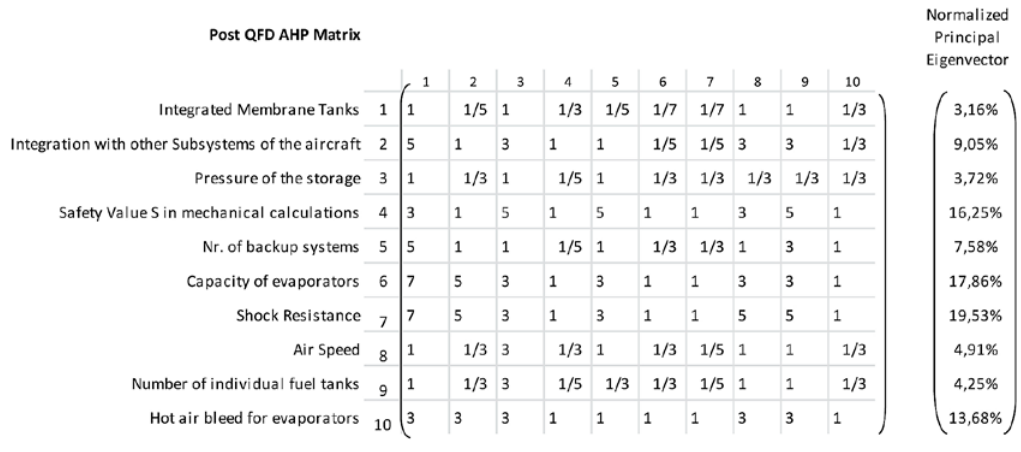
Fig. 5. The Post QFD AHP